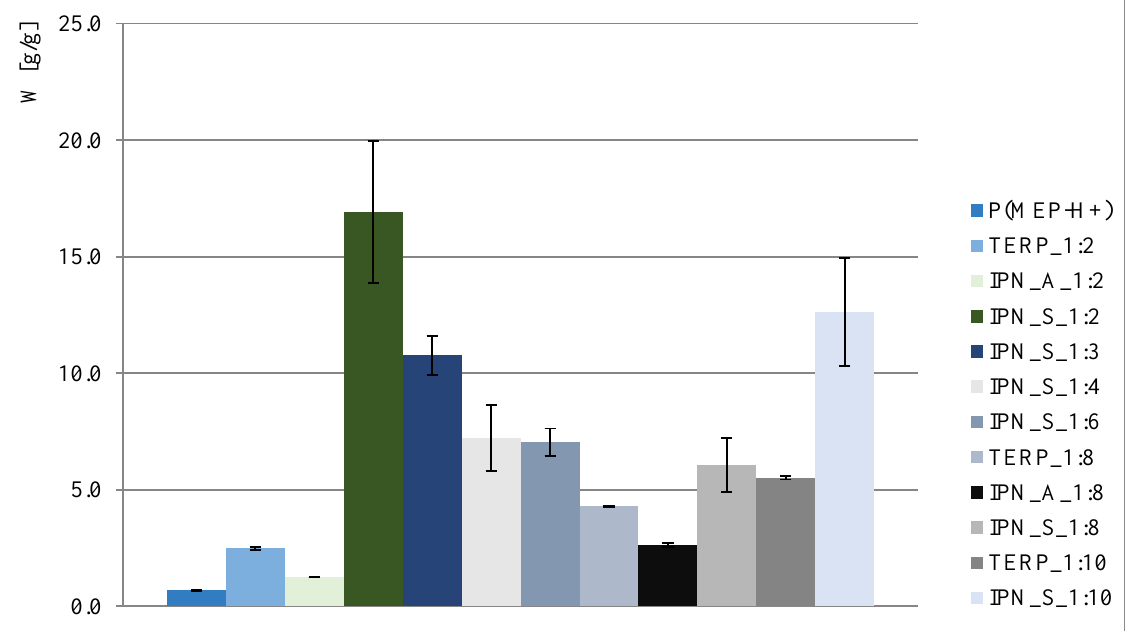
Figure 2. Water regain of polymers in acidic form.